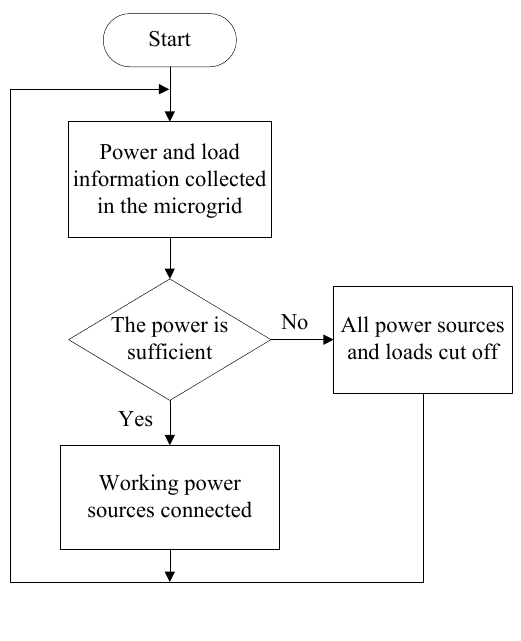
Figure 16. Flowchart of the power failure